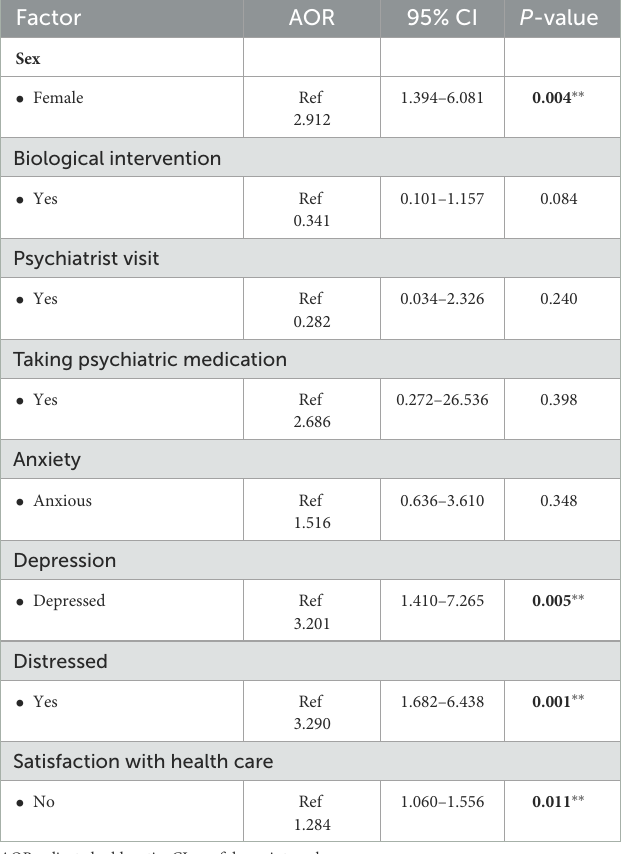
TABLE 4 Multivariate regression analysis to determine the factors associated with poor quality of life among cancer patients. Factor AOR 95%